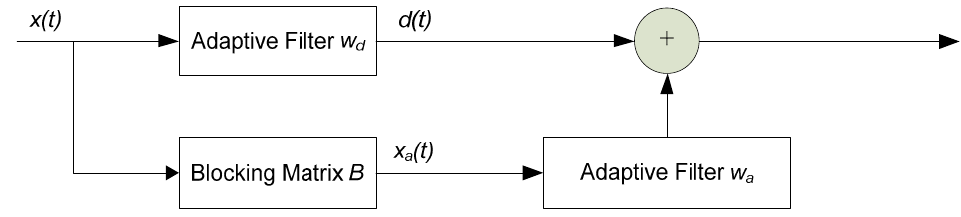
Figure 3. Processing diagram of the generalized sidelobe canceller.